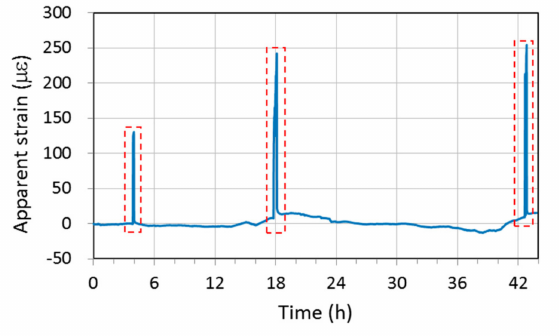
Figure 13. The apparent strain response of the nonelastic response test for the concrete